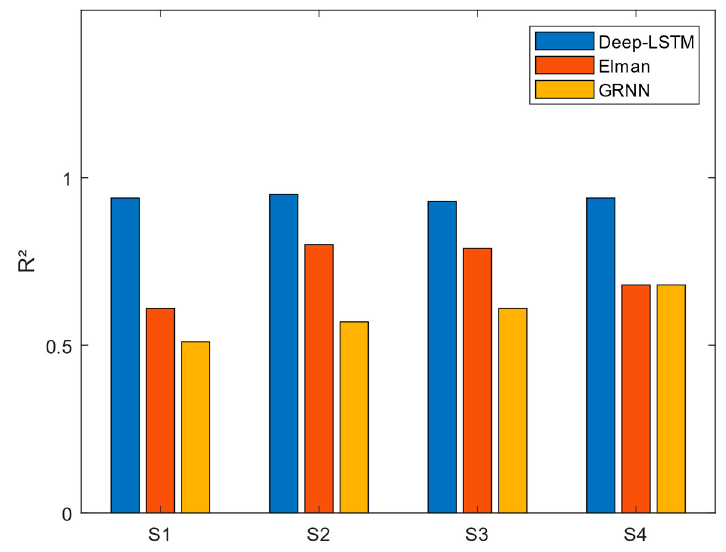
Figure 7. R 2 performance comparison results between LSTM and MLNN for the prediction of SM and SEC.